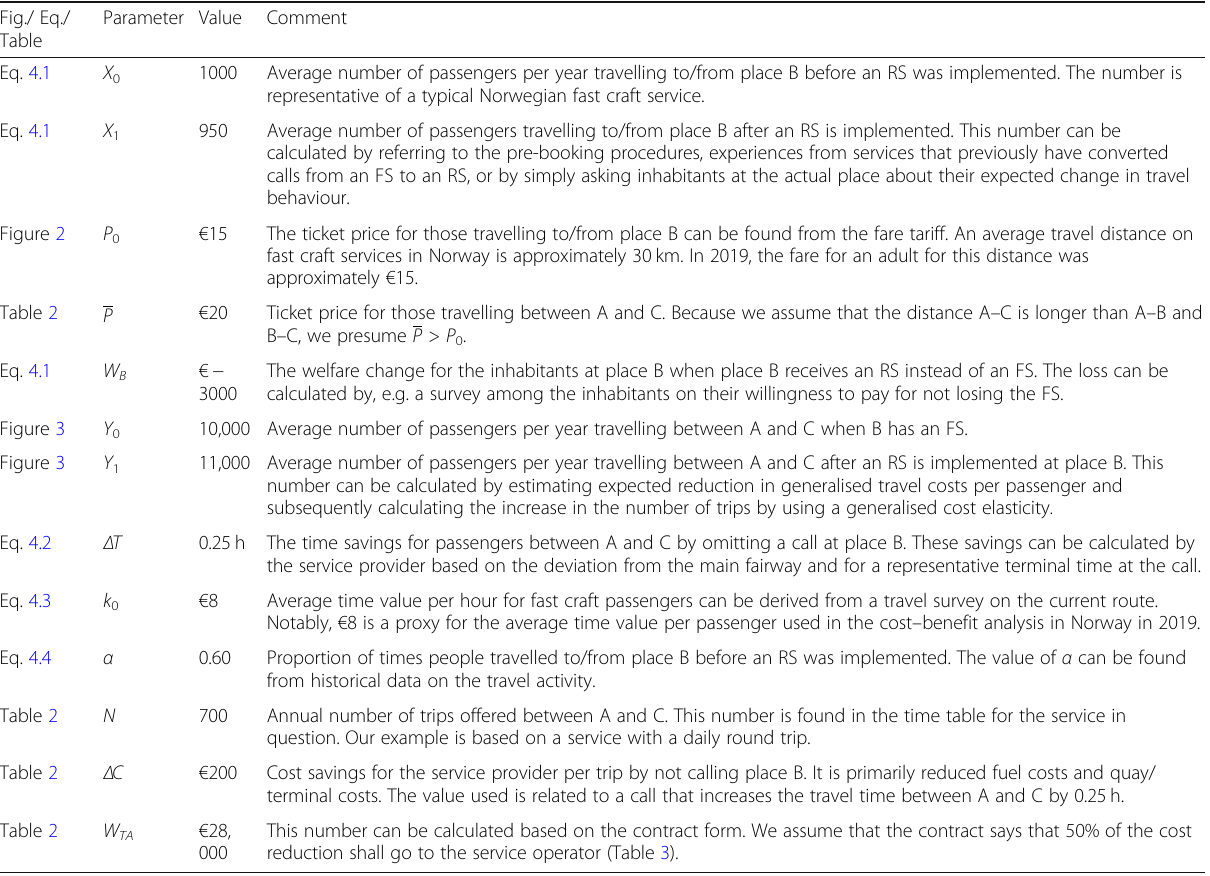
Table 2 Parameter values used in the calculation example with comments Fig./ Eq./ Parameter Value Comment Table